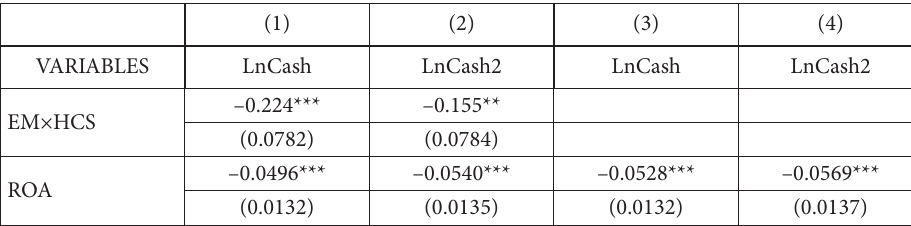
Table 6. Earning management and cash